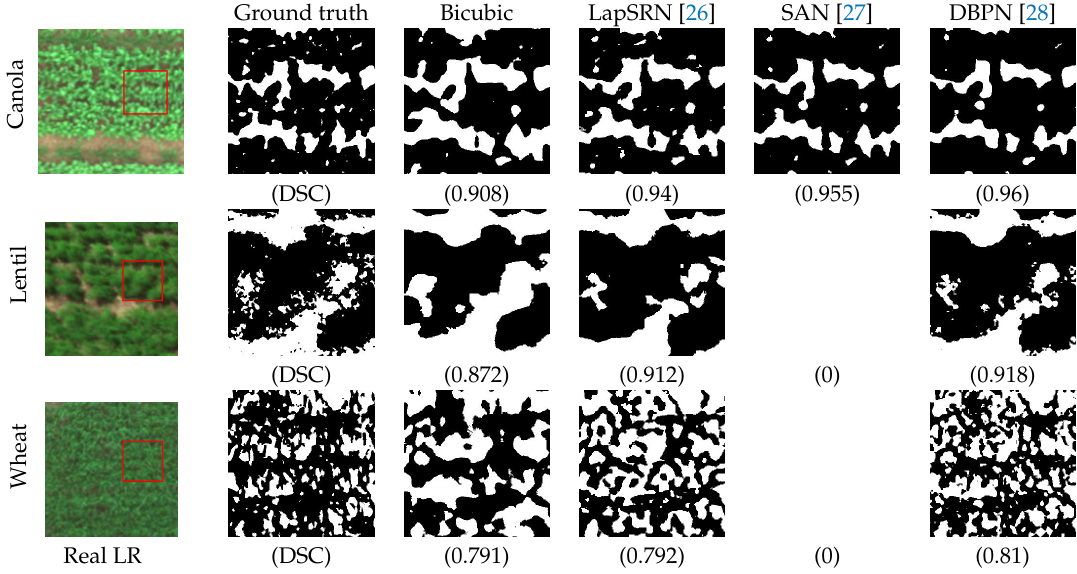
Figure 10. Example test images from the real-real experiment for canola, lentil and wheat datasets (top/middle/bottom rows). Ground truth HR images (left) are shown with the cropped region denoted by a red box. Black pixels indicate vegetation segmentation (foreground) and DSC values are listed below each image.